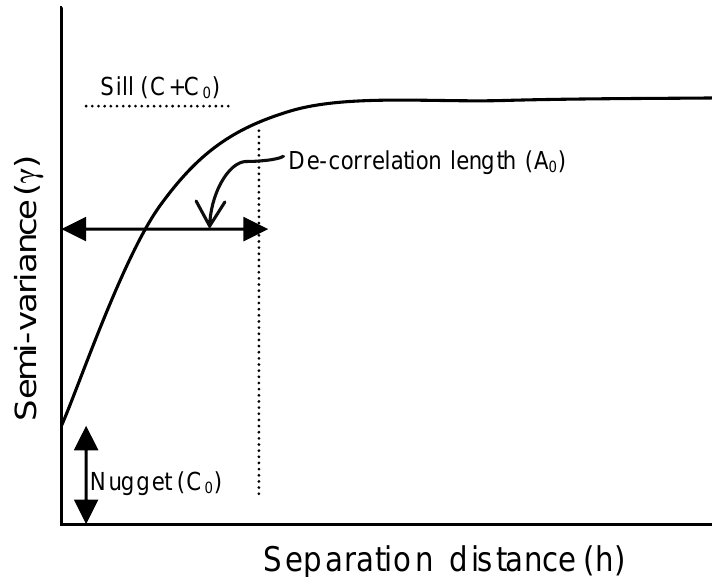
Figure 3. A generalized variogram model shows the essential components: nugget is the y-intercept that represents the semi-variance between two closest points; Sill signifies maximum semi-variance; and decorrelation length measures spatial